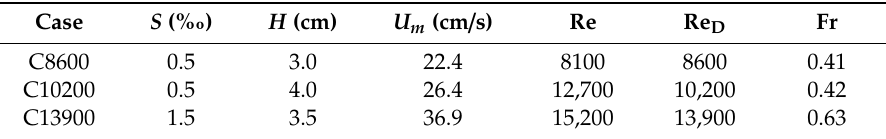
Table 1. Details of the bed and flow characteristics: S , bed slope; H , water depth; U m , bulk mean velocity; Re, Reynolds number.